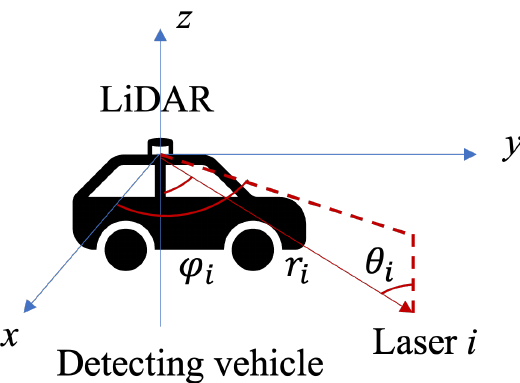
Figure 2. The coordinate of LiDAR on the Detecting vehicle.